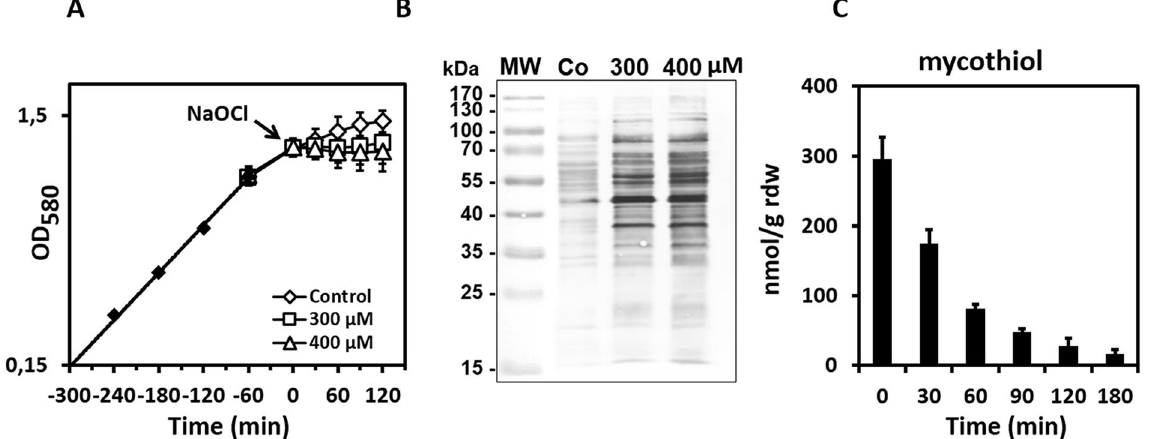
Figure 1. Protein S -mycothiolation pattern and MSH depletion in C . diphtheriae under NaOCl stress. C . diphtheriae was grown in HIB medium to an OD 580 of 0.75–0.8, transferred to BMM and treated with 300 and 400 µ M NaOCl which resulted in growth delay (A) and strongly increased protein S -mycothiolation as revealed by non-reducing MSH-specific Western blots (B) . The level of reduced MSH was 0.3 µ mol/g rdw in the control and strongly depleted under NaOCl stress in the thiol-metabolome indicating that MSH is used for protein S- mycothiolation (C) . All data represent mean values of three independent biological replicates and the error bars given were calculated as standard error of the mean